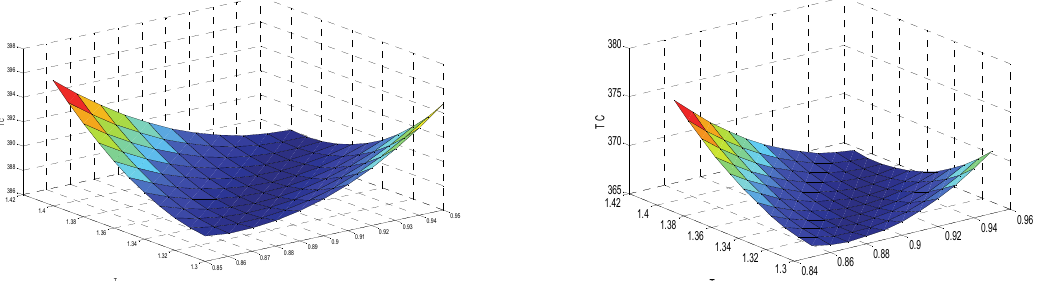
Fig. 3. Convexity of total cost function for example 1 Fig. 4. Convexity of total cost function for example 2